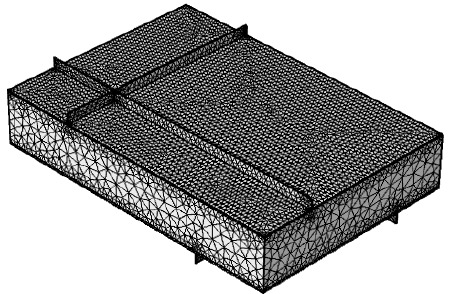
Figure 3. The finite element model of the rib stiffened double-panel structure.